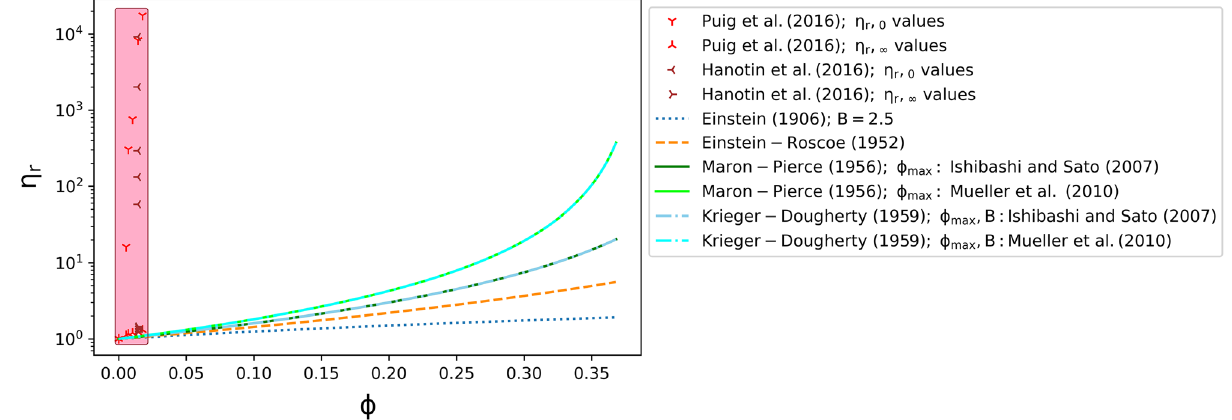
Figure 3. Relative viscosity as function of crystallinity for the collated literature data on PGE-bearing melts obtained at η r,0 and η r, ∞ compared to different rheological models. The considered parameters are labelled for the models.